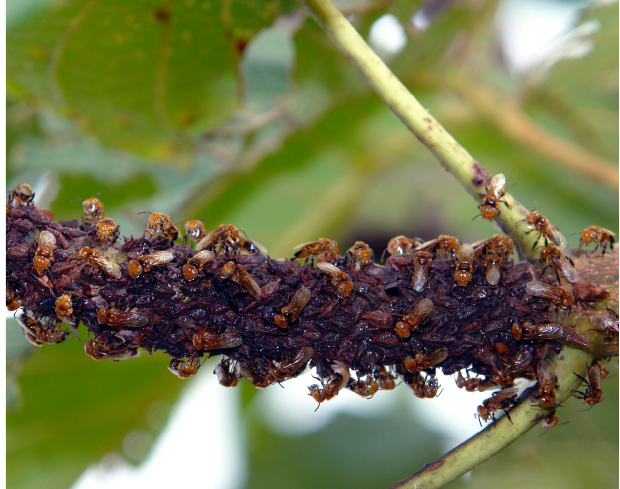
Fig 1 . Oxytrigona tataira (Smith) (Hymenoptera: Apidae: Meliponini) collecting honeydew from Erechtia carinata (Funkhouser) (Hemiptera: Membracidae) on branch of Caryocar brasiliense Cambessèdes (Malpighiales: